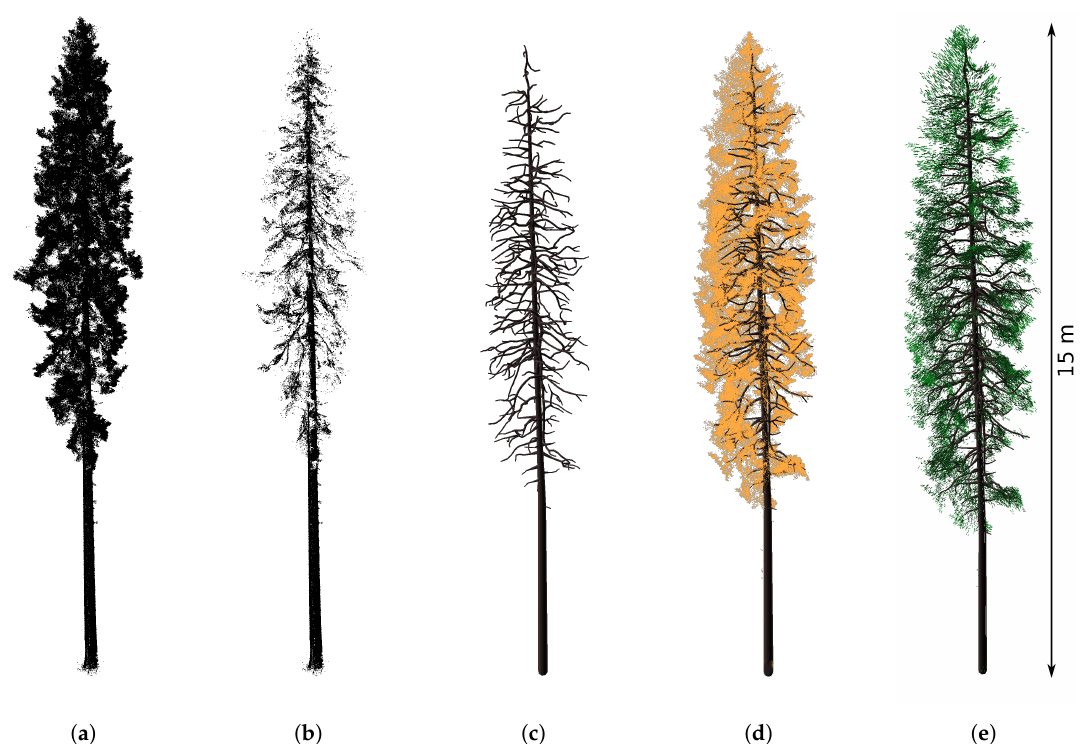
Figure 3. Reconstruction of a 3D spruce tree representation from terrestrial laser scanning data: ( a ) original terrestrial laser scanning (TLS) scan of a spruce tree, ( b ) point cloud separated into wooden elements, ( c ) reconstructed wooden skeleton, ( d ) reconstructed wooden skeleton with a scaled foliage point cloud, and ( e ) final 3D spruce tree representation populated by shoots of two age categories (current-year shoots in light green, earlier-year shoots in dark